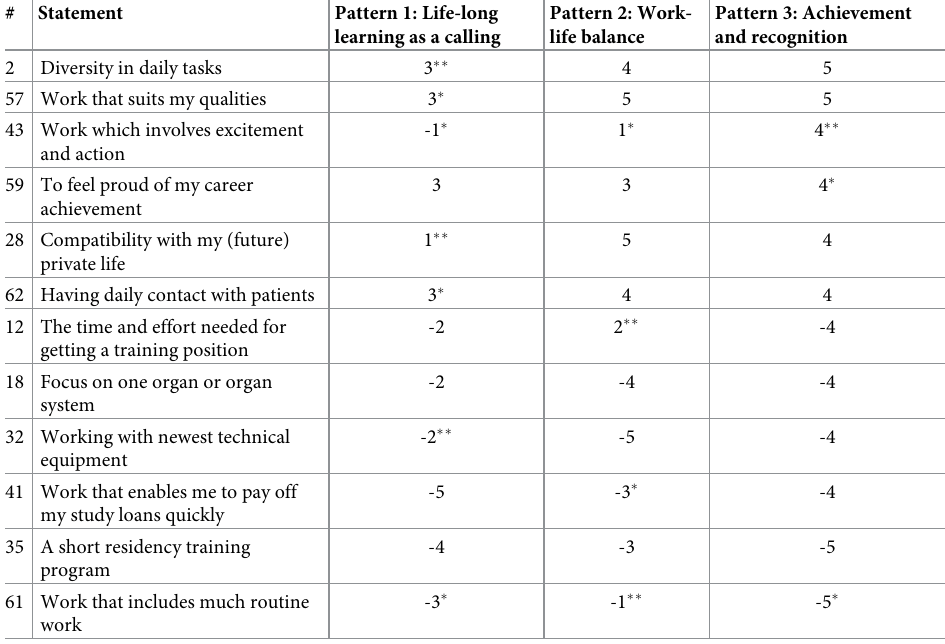
Table 5. Characterising statements pattern 3.